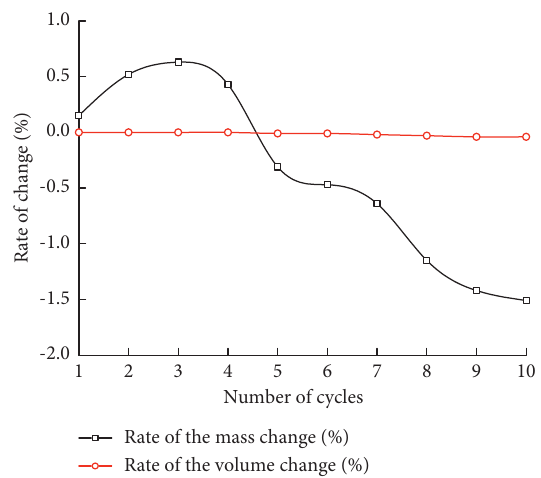
Figure 4: Variation curves of the physical parameters of weakly cemented sandstone under different numbers of dry-wet cycles.